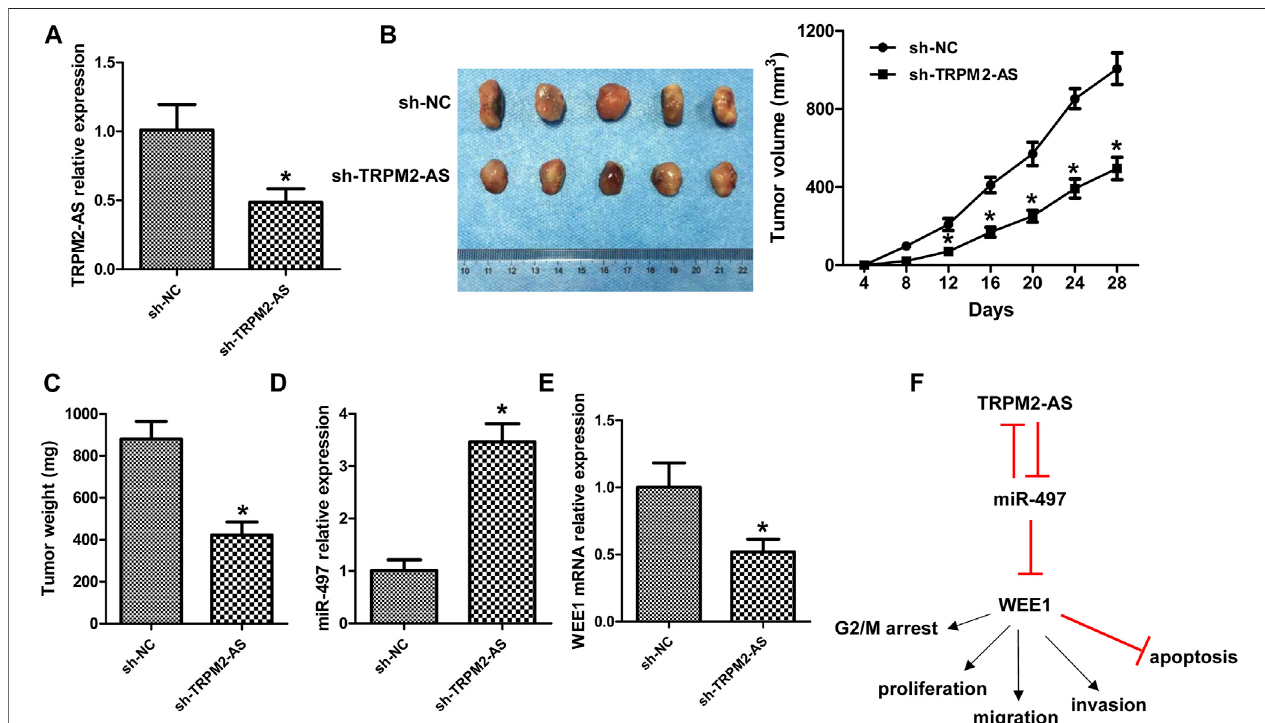
FIGURE8| KnockdownofTRPM2-ASsuppressedtumorgrowth invivo . (A) TRPM2-ASexpressioninmousetumortissues. (B) Representativetumorimagesand the measurement of tumor volume in mice. (C) Tumor weight. The expression of miR-497 (D) and WEE1 (E) was analyzed in mouse tumor tissues. (F) Schematic diagram of TRPM2-AS in the development of RB. N (cid:2) 5, * p < 0.05 vs. the sh-NC